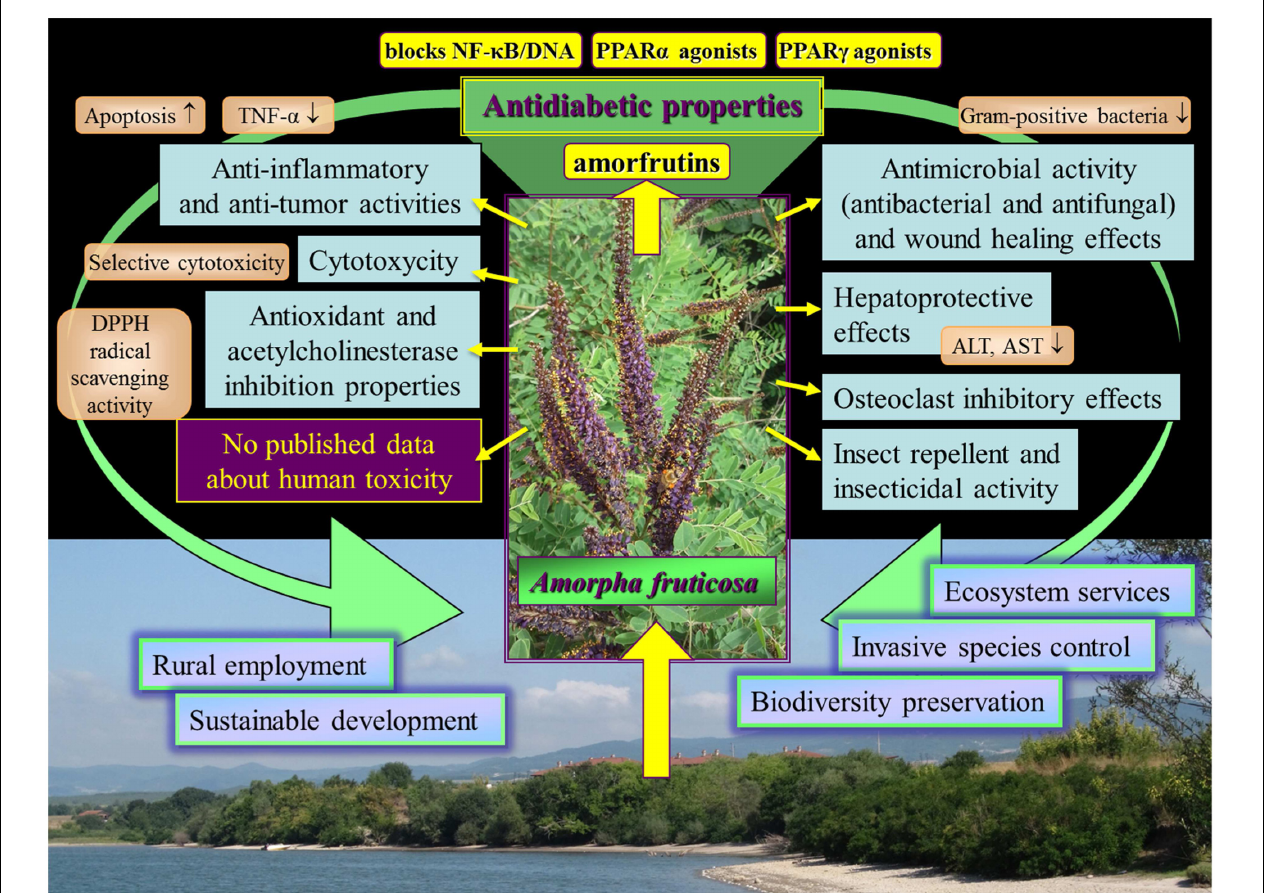
FIGURE 4 | Outline of the different bioeffects of Amorpha fruticosa reviewed in this work.